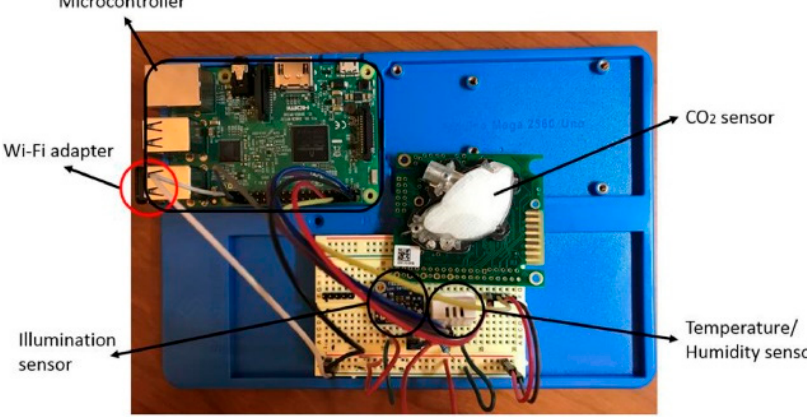
Figure 7. The integration of three sensors in Ref. [105].